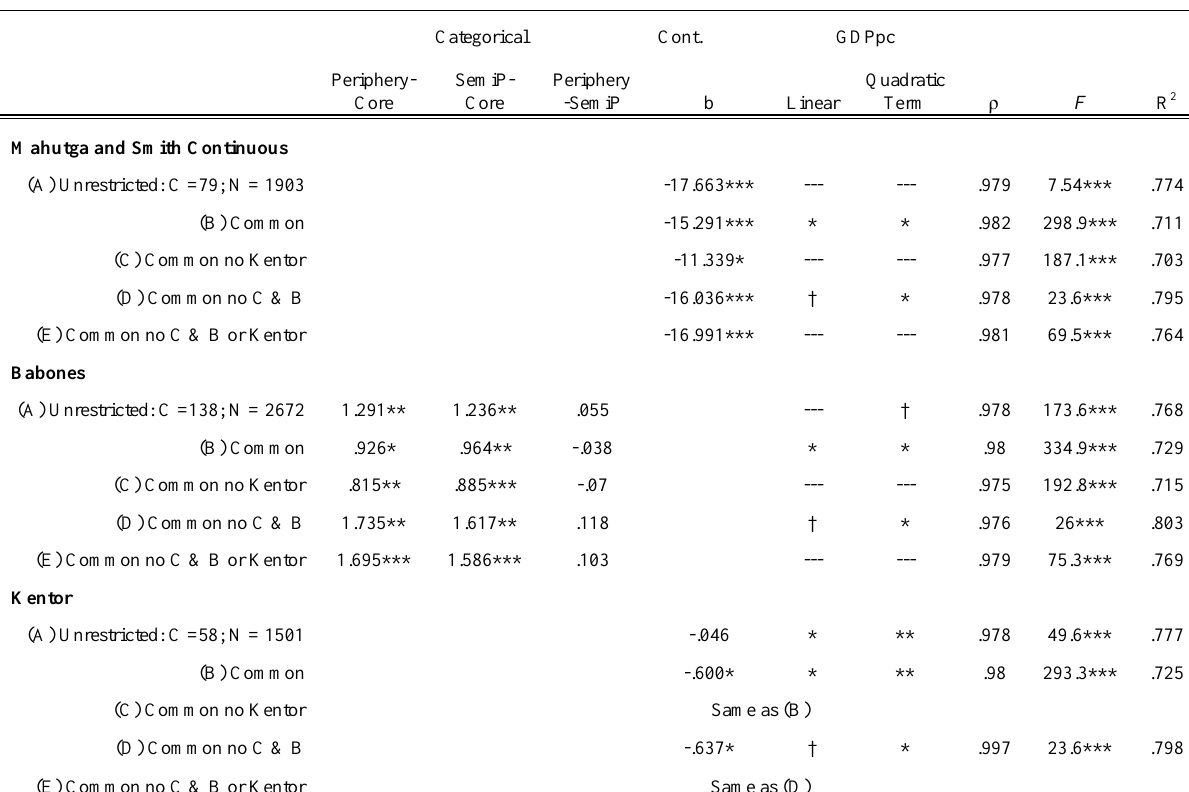
Table 4. Summary of 52 Regressions of Gini on World-System Position and Development Quadratic